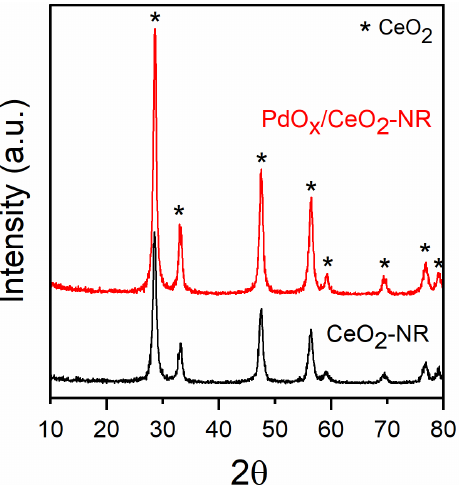
Figure 1. X-ray diffraction (XRD) patterns of the CeO 2 -NR and PdO X /CeO 2 -NR samples. Table 1. Crystallite size and cell parameters of CeO 2 and textural properties of samples.